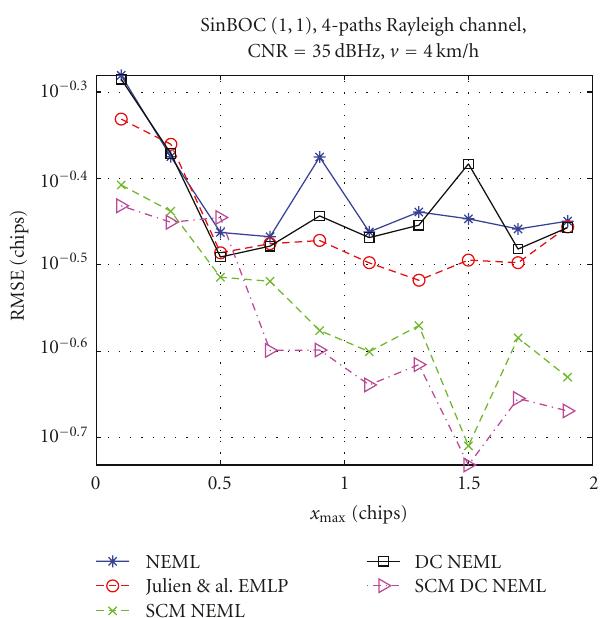
Figure 26: Comparison of feedback delays estimation algorithms employing the NEML discriminator and of the Julien&al. EMLP method, as a function of separation between successive channel paths xmax, in terms of RMSE; SinBOC(1,1) modulation, 4-paths Rayleigh channel, mobile speed 4 km/h, CNR =